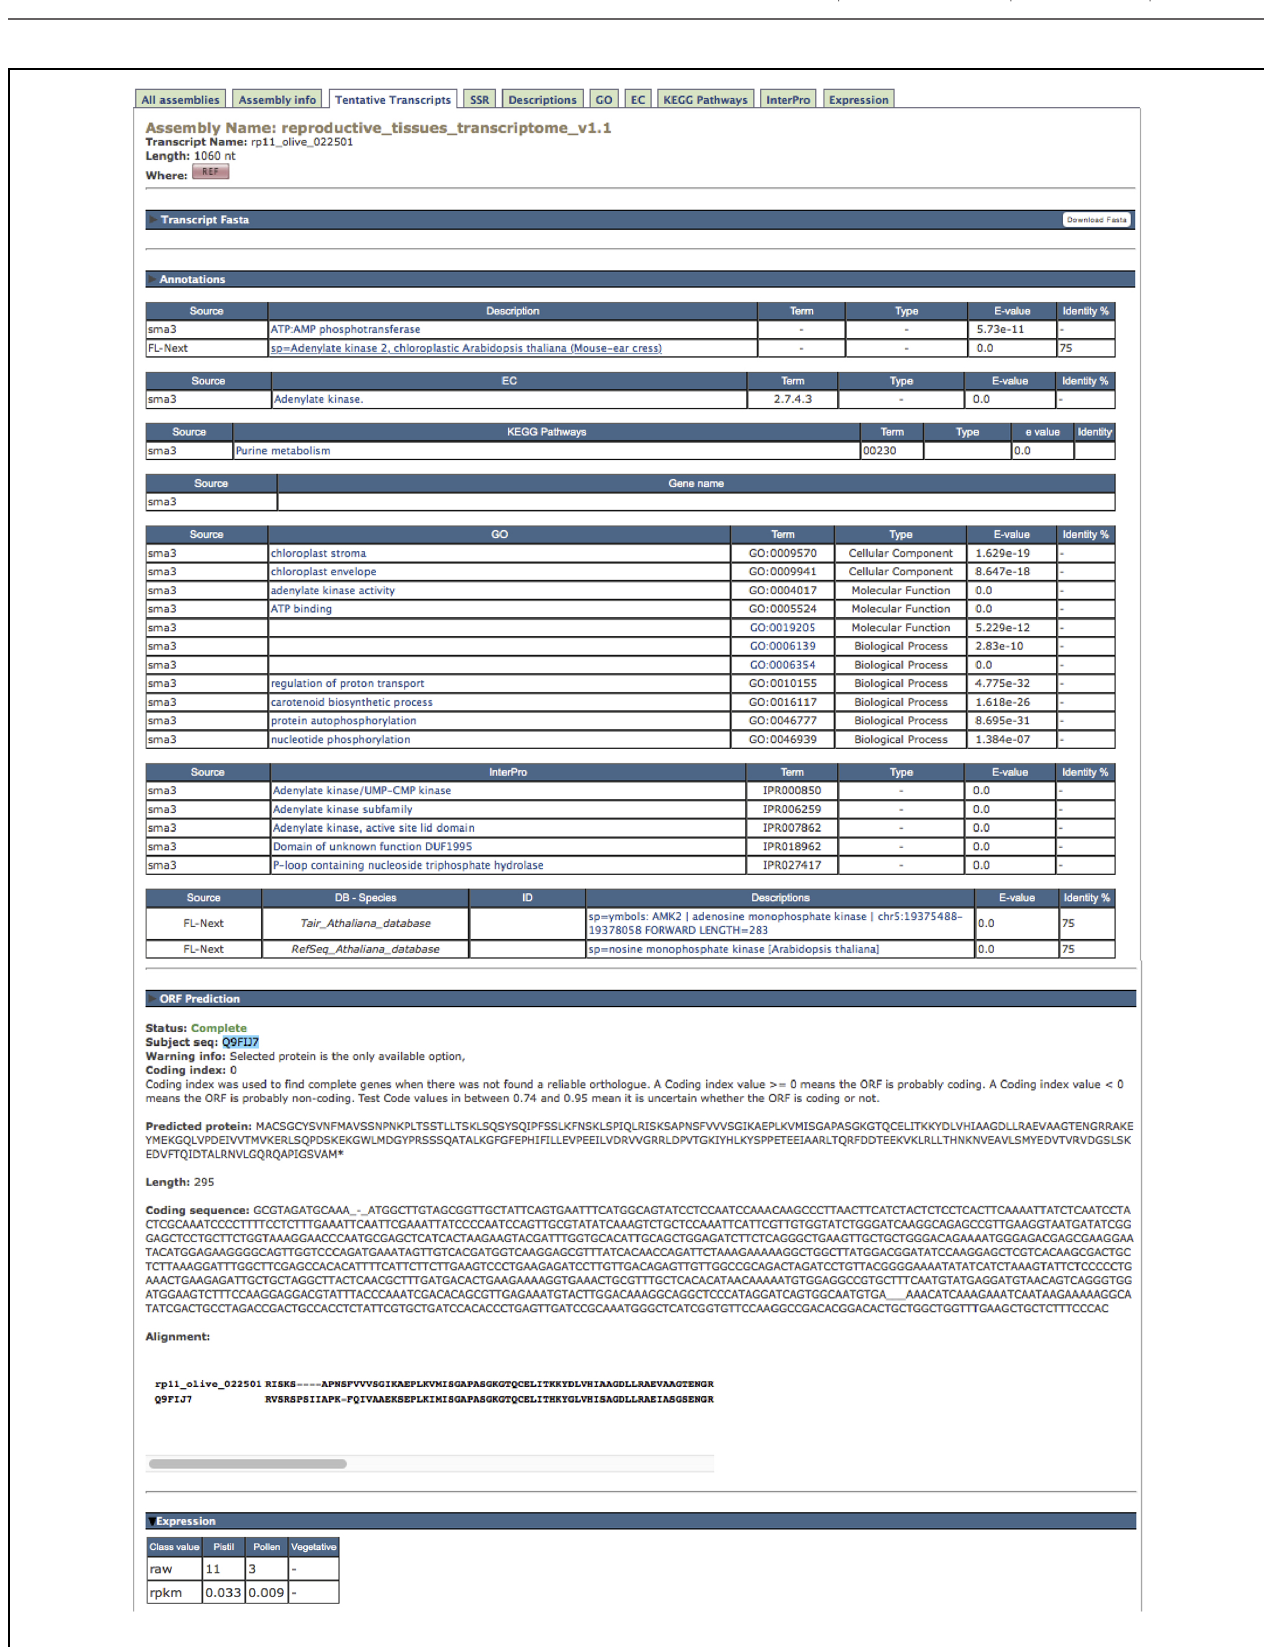
FIGURE 3 | Information shown for one single TT, i.e., ‘rp11_olive_022501’ corresponding to an adenylate kinase where the “Annotation” and “ORF prediction” pop-up texts are deployed. See text for details.